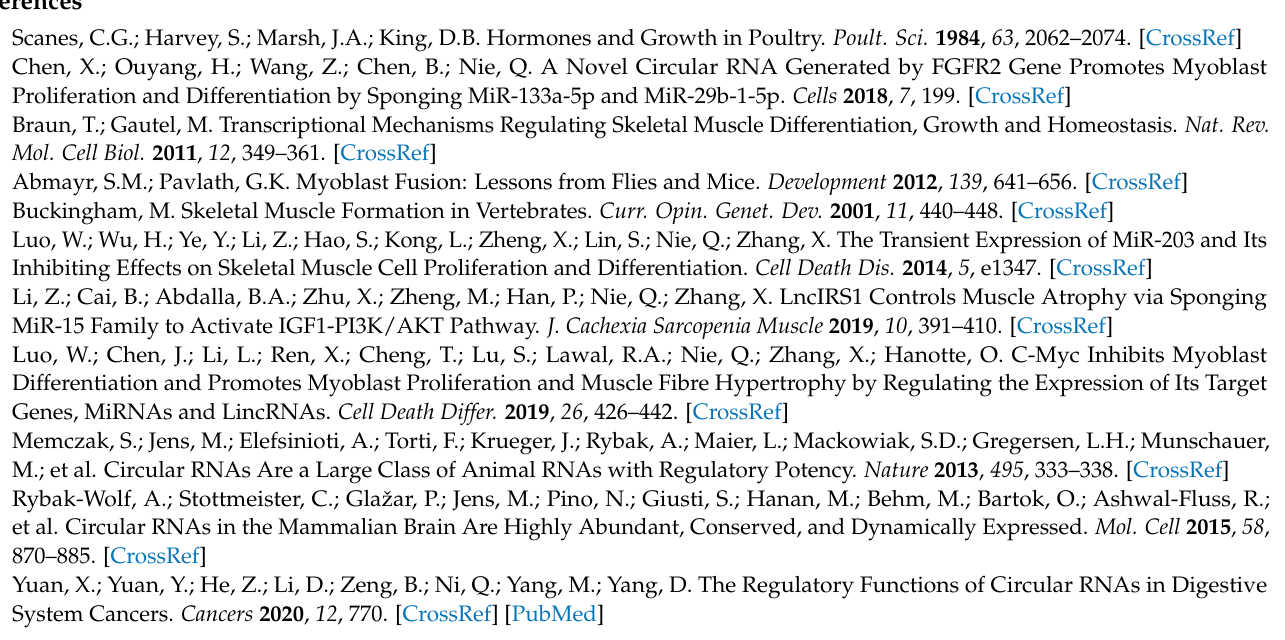
Table S3: The statistical result of the circular RNA identification; Table S4: The results of the GO enrichment; Table S5: The results of the KEGG enrichment